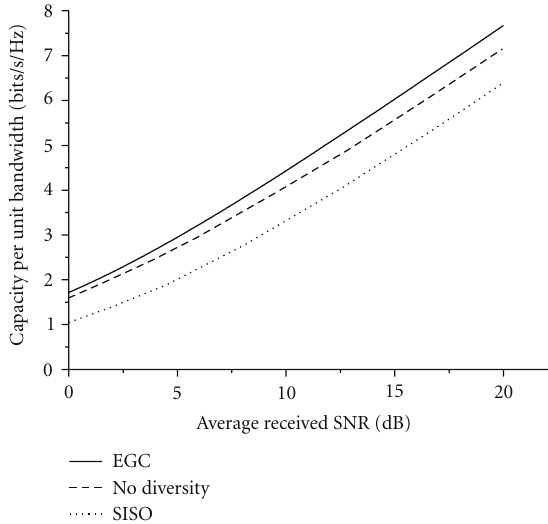
Figure 1: Capacity per unit bandwidth of a dual branch Nakagami- m fading channel with MRC diversity as a function of the average received SNR.